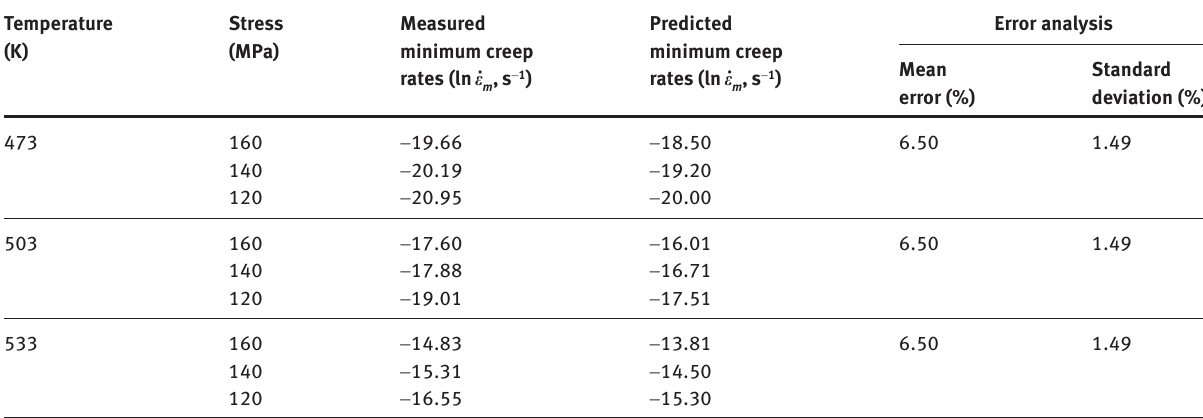
Table 3: Comparison between the predicted and experimentally obtained minimum creep rates of 2124-T851 aluminum alloy.